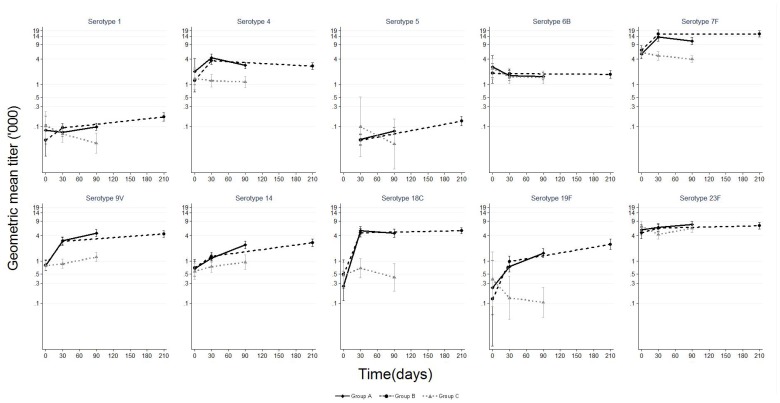
Pneumococcal serotype-specific opsonophagocytic activity geometric mean titer before and after PHiD-CV or control vaccine.Pneumococcal serotype-specific opsonophagocytic activity geometric mean titer and 95% confidence interval among children aged 12–59 months before and after PHiD-CV (Groups A and B) or control vaccine (Group C). Group A N (range) by day: day 0 (0–110); day 30 (66–124); day 90 (104–121) Group B N (range) by day: day 0 (0–102); day 30 (60–119); day 210 (97–115) Group C N (range) by day: day 0 (3–109); day 30 (2–118); day 90 (2–118) Results for serotype 5 at day 0 not available because of insufficient specimen volume.